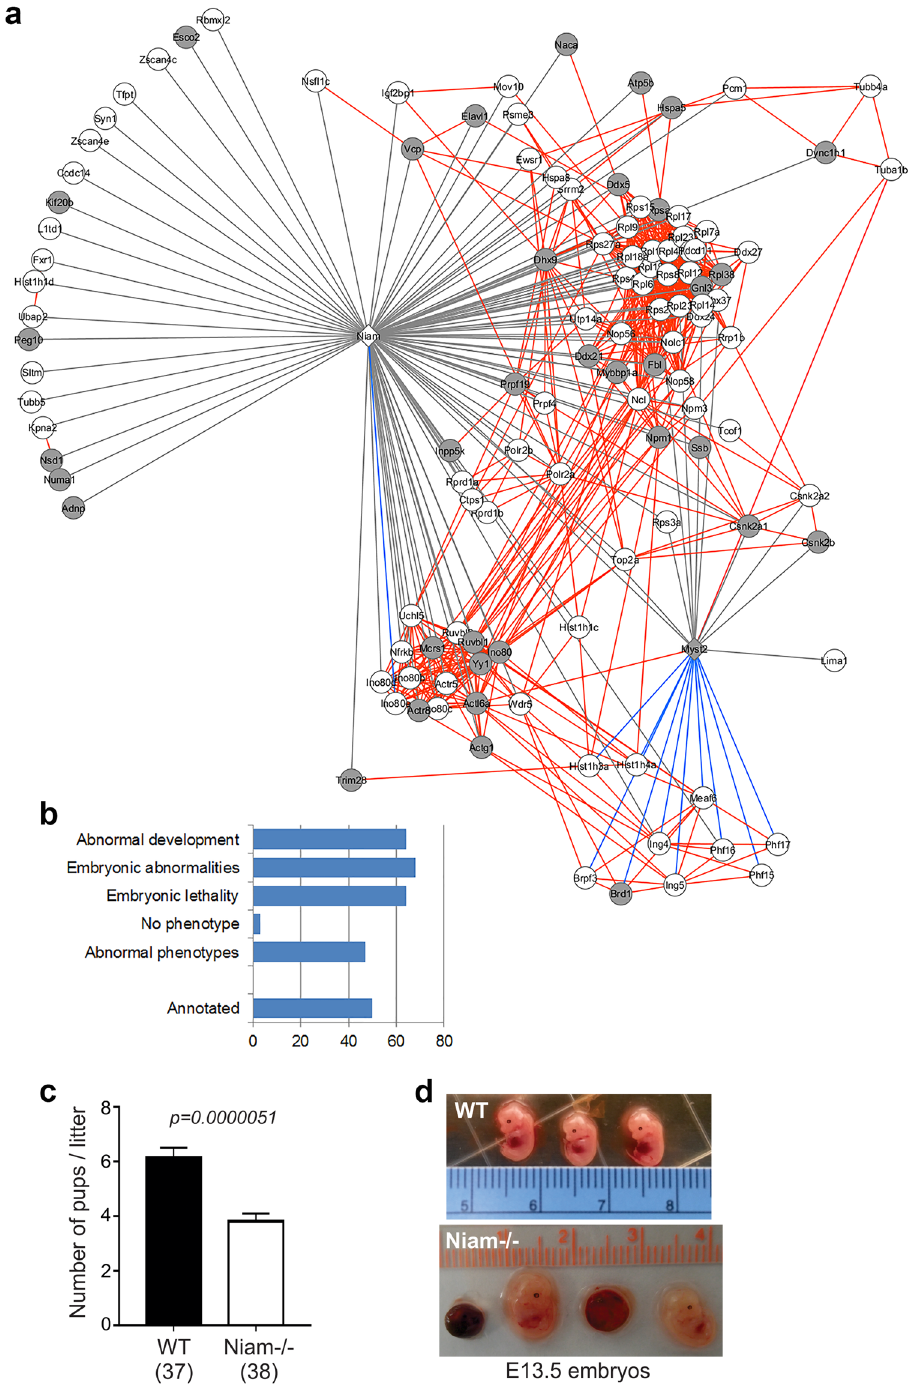
Figure 5. Extended Myst2-Niam protein interactome and role for Niam in embryonic development. ( a ) Myst2 and Niam are shown as diamonds. Grey edges represent interactions observed experimentally in our study. Red edges represent known physical interactions retrieved from STRING and literature. Blue edges represent interactions observed in this study that had previously been reported. Light grey nodes are genes whose loss- of-function results in embryonic lethality. ( b ) Distribution of loss of function phenotypes. Numbers shown are percentage of genes with MGI annotation. ( c ) Litter sizes at birth for wild-type (WT) and Niam − / − mice. The number of litters studied is indicated in parentheses, and results are presented as the mean + / − sem. Statistical significance was determined by an unpaired 2-tailed Student t -test ( p = 0.0000051). ( d ) Comparative images of embryos isolated from WT or Niam − / − pregnant females at embryonic day 13.5